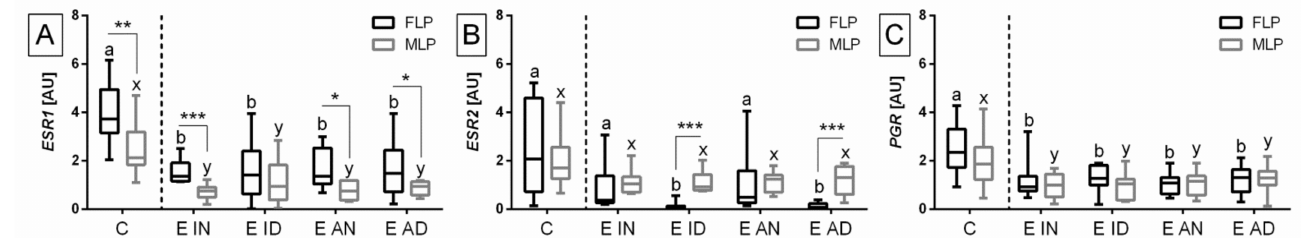
Figure 4. Transcription levels of ( A ) estrogen receptor α ( ESR1 ), ( B ) estrogen receptor ß ( ESR2 ), and ( C ) progesterone receptor ( PGR ) in the mares’ endometria in follicular (FLP; n = 50) or